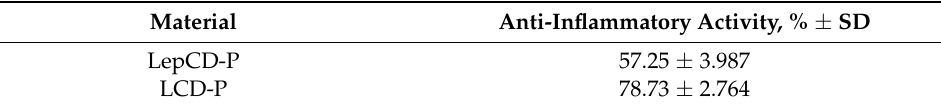
Table 4. Anti-inflammatory activity of materials containing